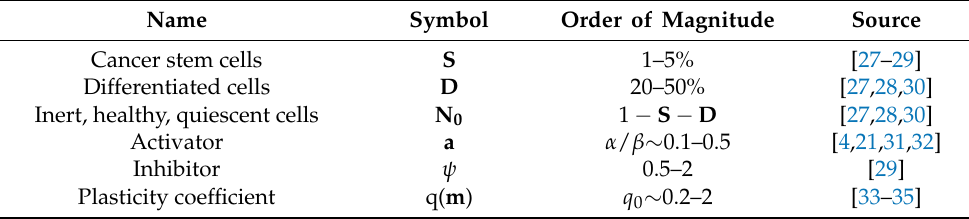
Table 1. Dynamical variables of the basic